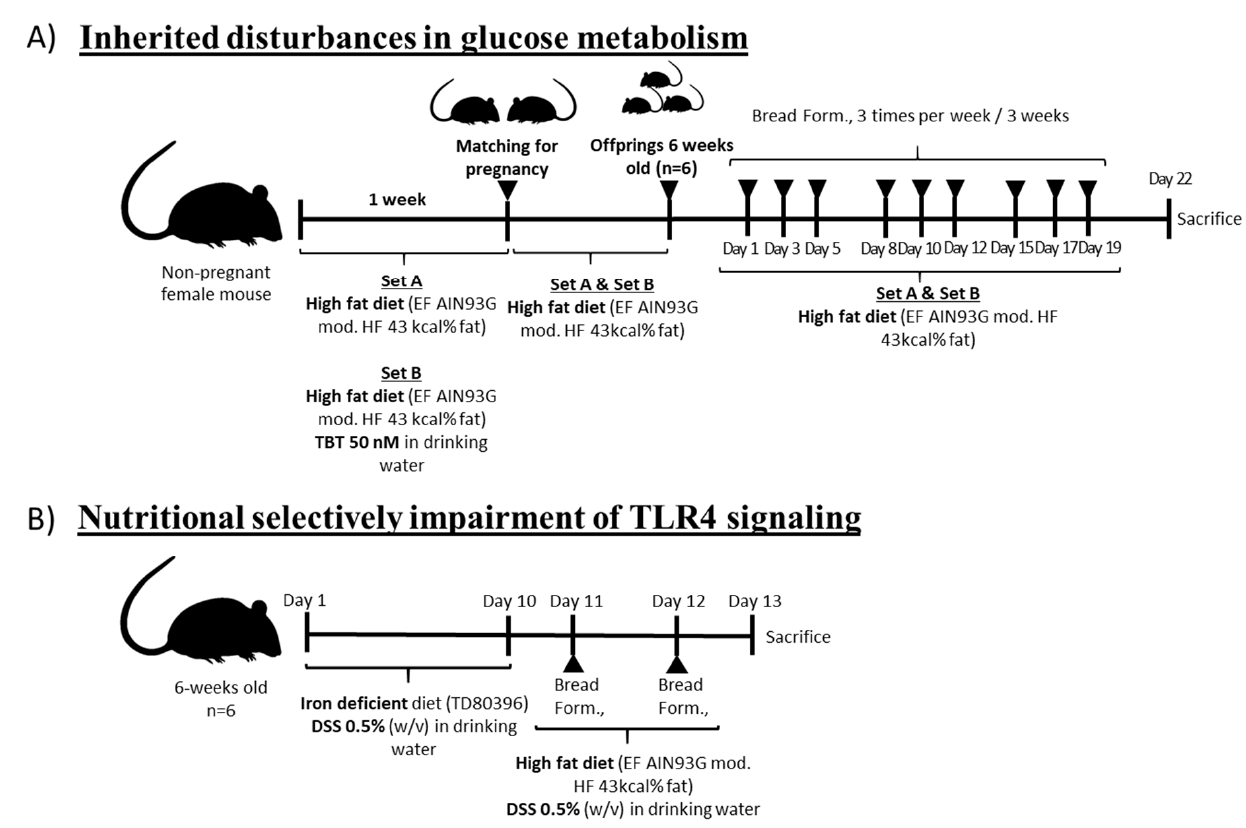
Figure 1. Schematic representation of the two experimental models used to mimic early disturbances in glucose homeostasis and the administration pattern for the bread formulations (bread form: wheat-, Chenopodium quinoa - and Salvia hispanica - based bread formulations. Model 1 ( A ): Male animals (n = 6/group) were split into two groups depending on their origin; (i) pregnant female mice under standard conditions (F0_A) or (ii) pregnant female mice exposed (F0_B) to the obesogenic tributyltin TBT 50 nM ( w / v ) via drinking water to develop a state of obesity [10]. After, both F1_A and F1_B generations were kept on a HFD until reaching 6 weeks of age. Model 2 ( B ): Male mice (n = 6/group, 6 weeks-old) from pregnant females under standard conditions were kept on an iron-deficient diet (AIN93G modified, Ssniff Spezialdiäten GmbH, Soest, Germany), exposed to 0.5%, and administered with dextran sulfate sodium (DSS) ( w / v ) via drinking water [27] for 10 days. After, animals were put on a HFD and continued to be exposed to 0.5% DSS for an additional 2